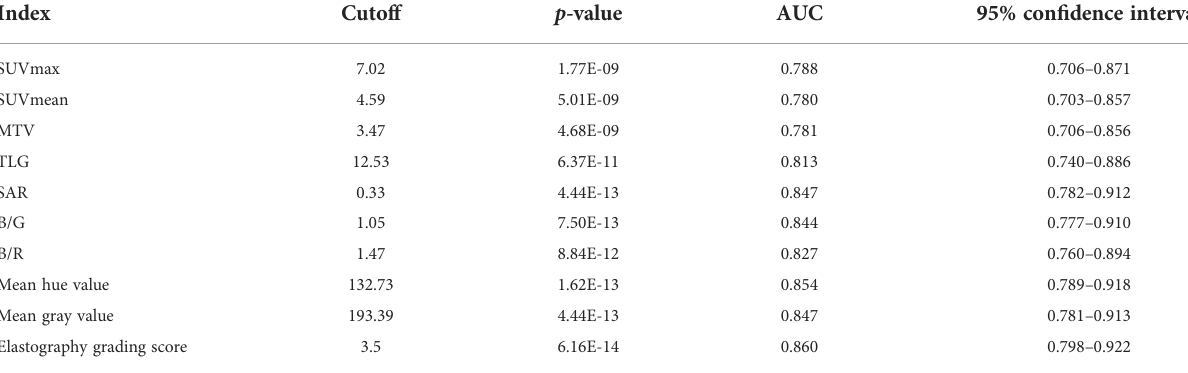
TABLE 2 Cutoff values and corresponding AUC of PET/CT and elastography variables for malignant LN prediction in the model